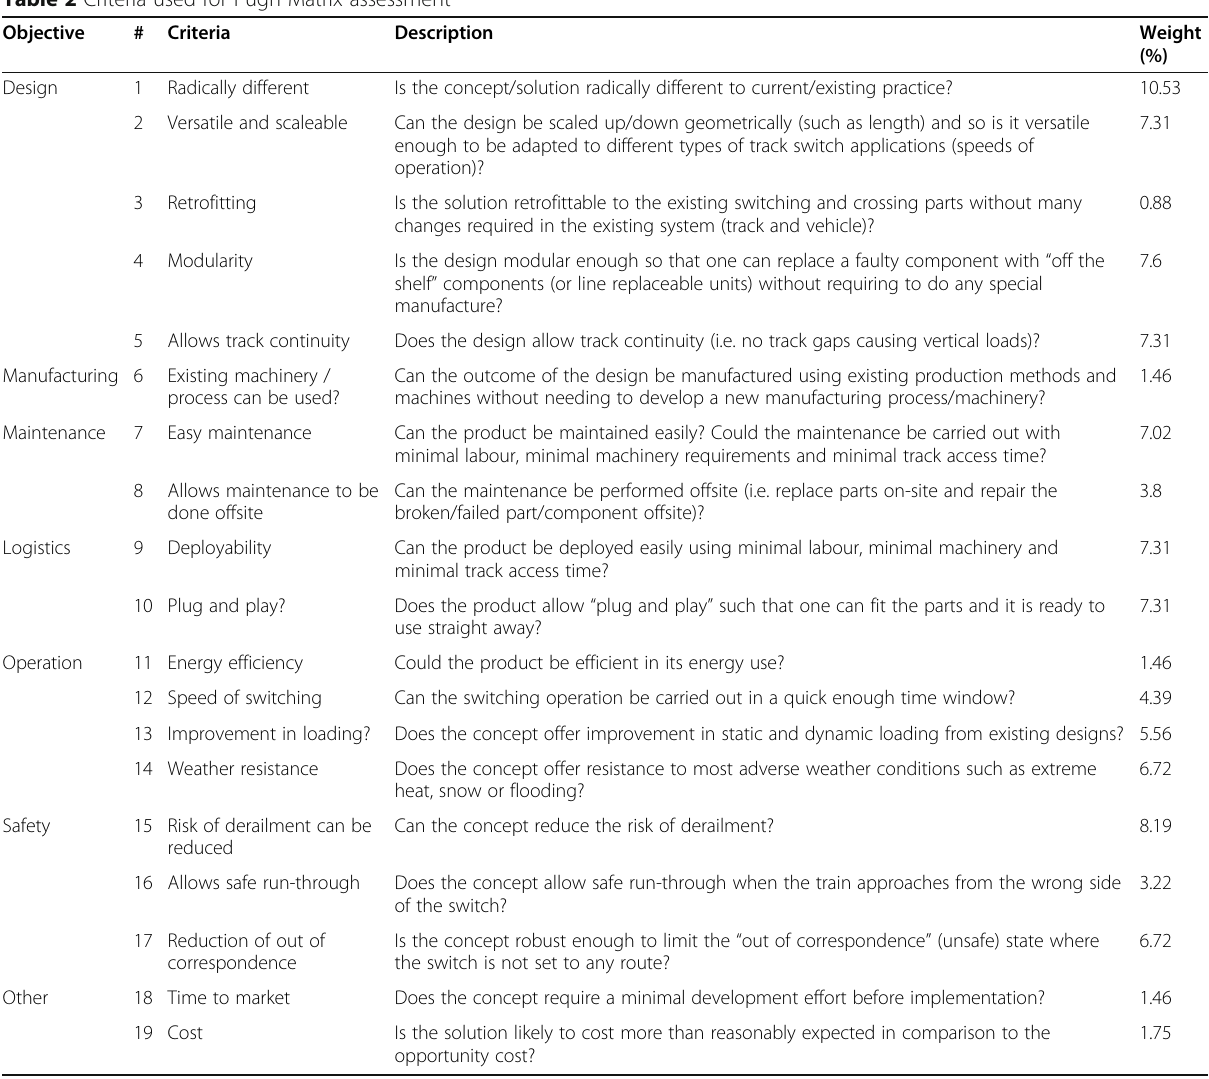
Table 2 Criteria used for Pugh Matrix assessment Objective